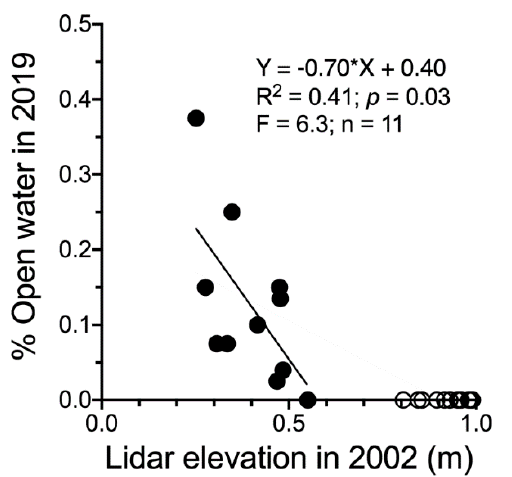
Figure 6. The percent of open water in 2019 and marsh elevation in 2002 for 27 natural marshes with 0% open water in 2002 at 50 to 125 m from the water’s edge. The data are divided into elevation data higher than 0.6 m elevation (open circles) and lower (filled circles). A simple linear regression is shown for the latter marshes.